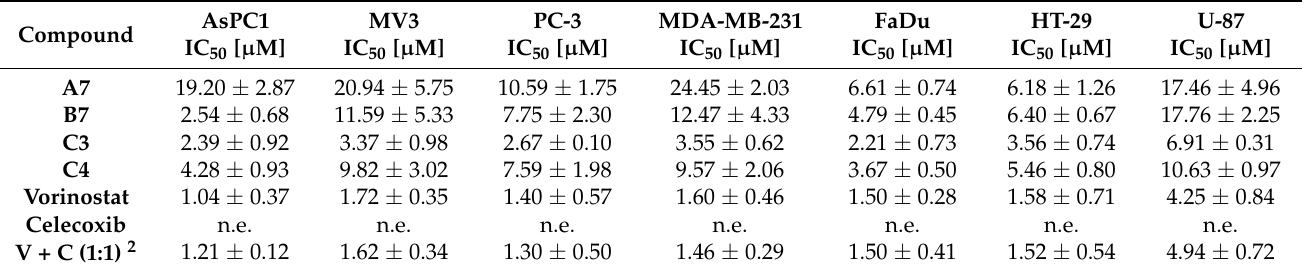
Table 3. Antiproliferative activity of A7 , B7 , C3 , and C4 against seven cancer cell lines of different tissue origins 1 .